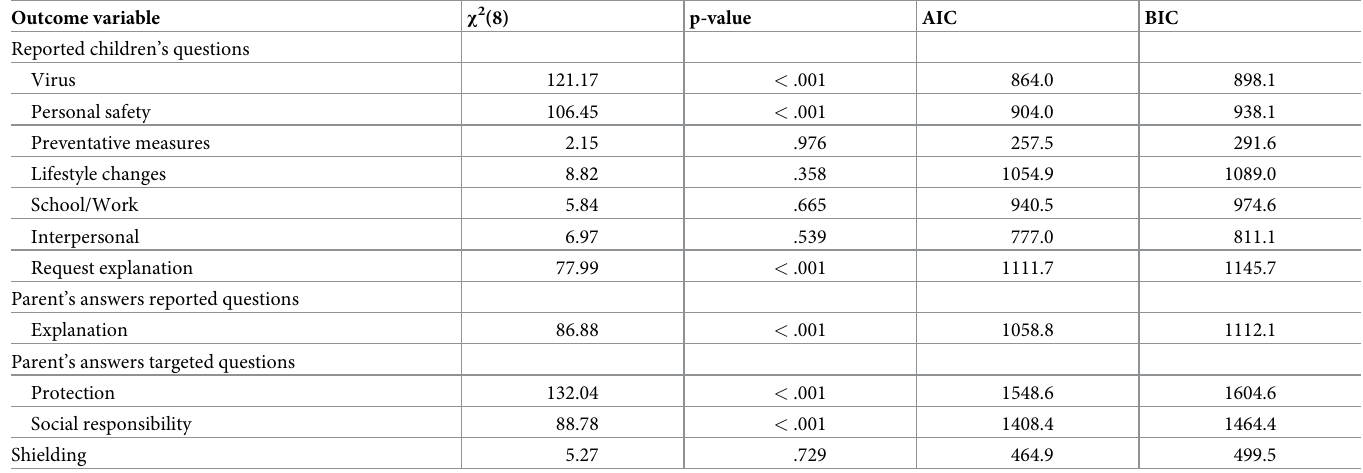
Table 6. Hosmer and Lemeshow goodness of fit test results AIC, and BIC for all the